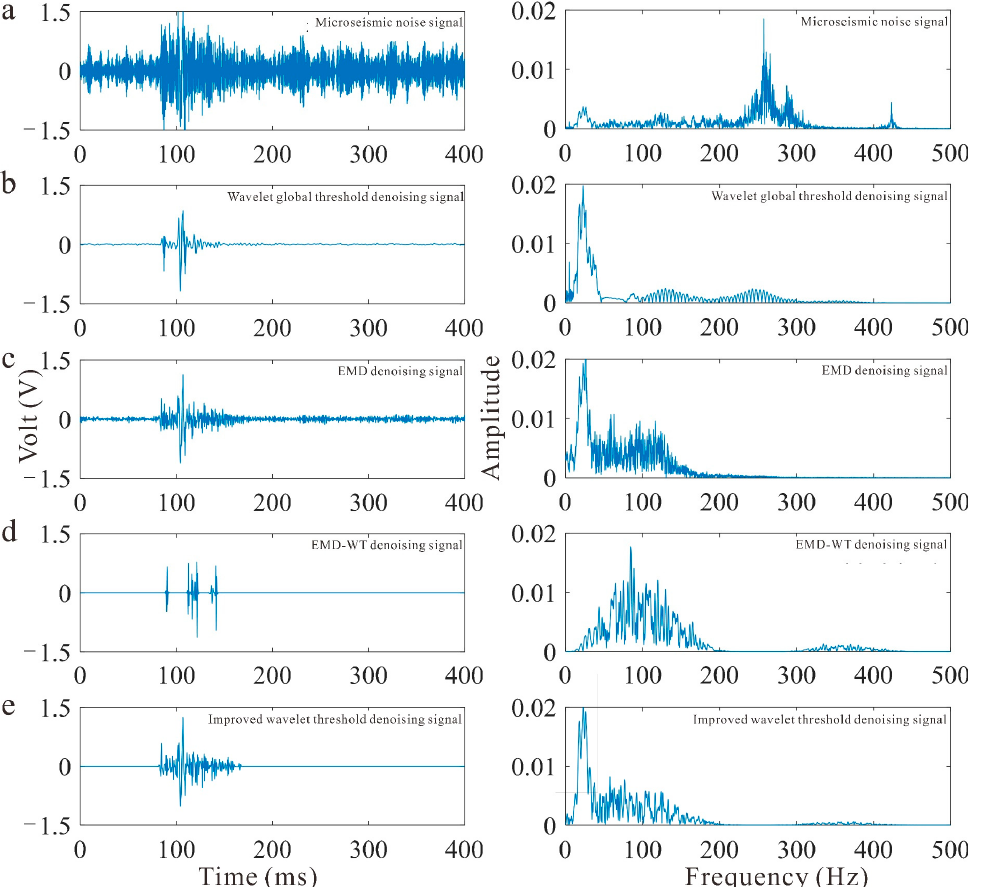
Figure 12. Comparison of denoising effects for an actual microseismic noise signal: ( a ) microseismic noise signal, ( b ) Wavelet global threshold denoising signal, ( c ) EMD denoising signal, ( d ) EMD-WT denoising signal, ( e ) improved wavelet threshold denoising